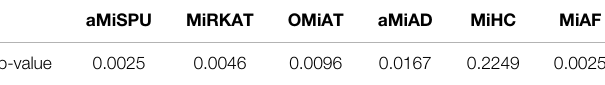
TABLE 3 | P-values of aMiSPU, MiRKAT, OMiAT, aMiAD, MiHC and MiAF for the association test between smoking status and throat microbial